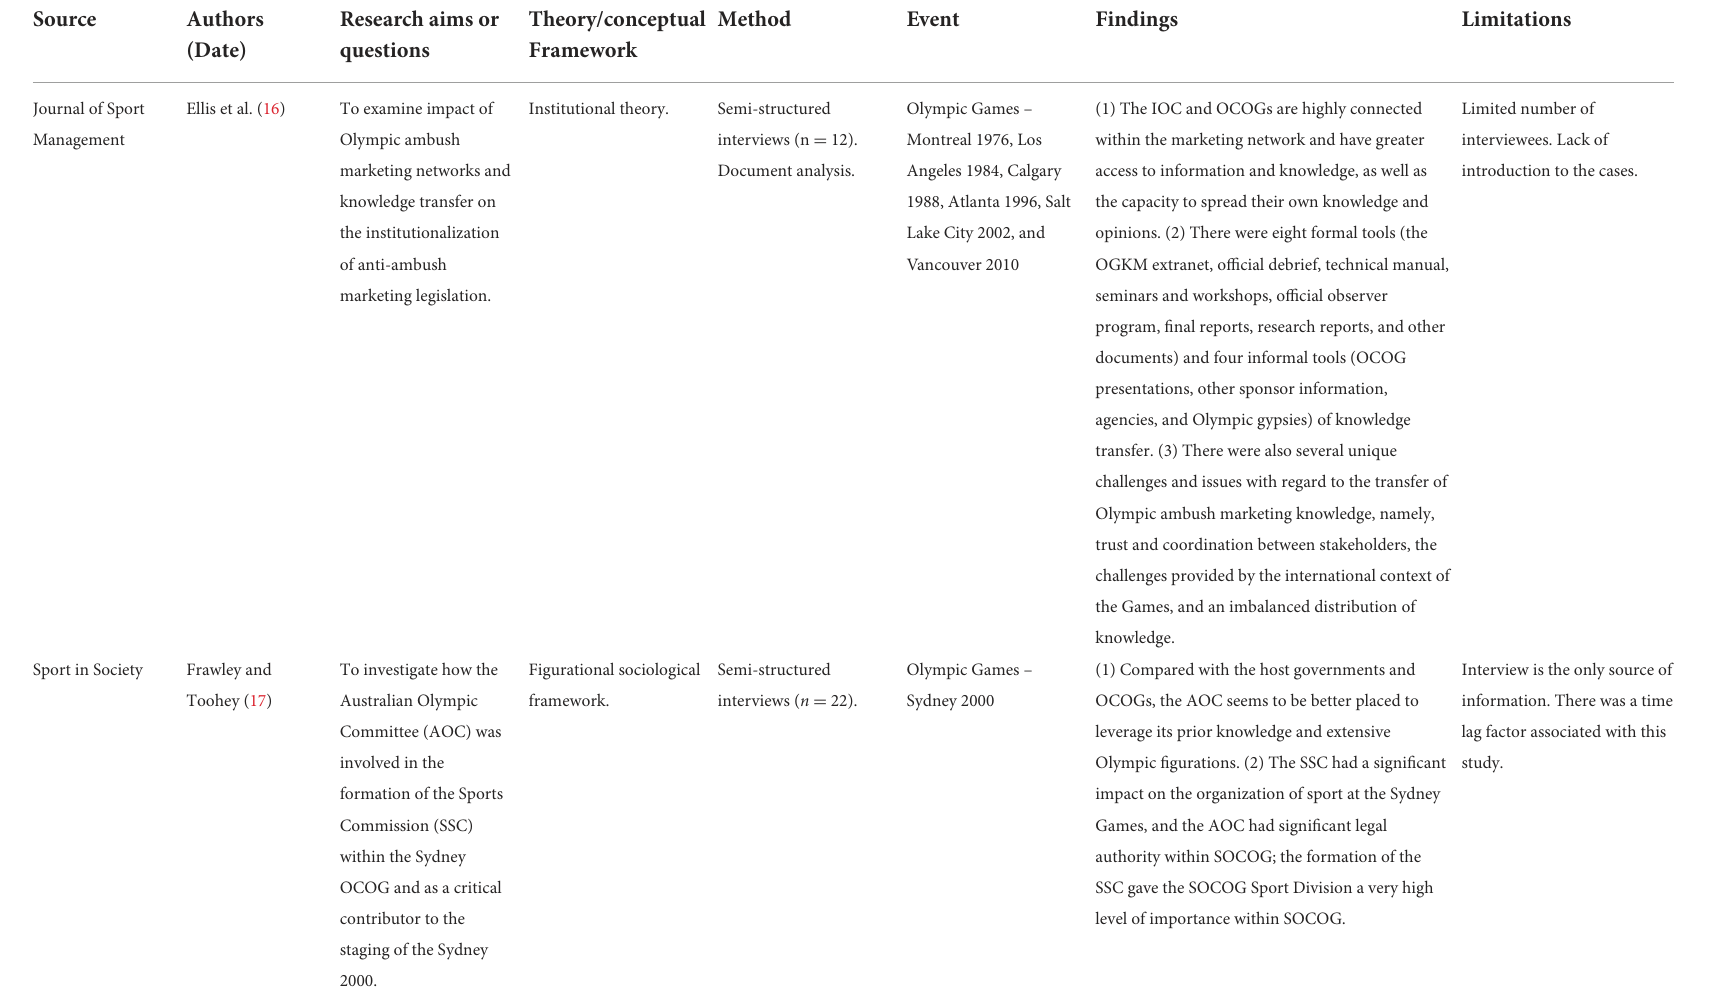
Figurational sociological